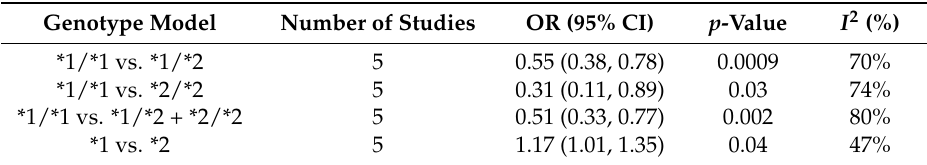
Table 4. The pooled ORs and 95% CIs of the association between ALDH2 rs671 and DM after removal of the work of Yakoyama (2013) [20].